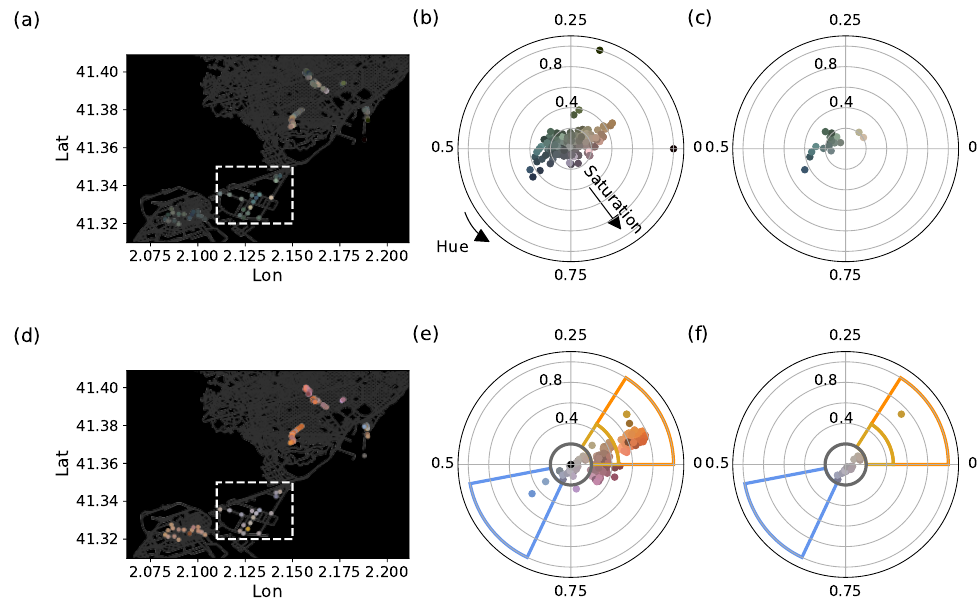
Figure 10. Analysis of an unlabelled dataset with the ISS ( top row ) and NightUp ( bottom row ). ( a , d ) Localisation of the streetlights photographed for the unlabelled dataset. The colour of the marker corresponds to the extracted colour for that localisation with the corresponding data source. ( b , e ) H-S scatter plot of the extracted colours from the previous unlabelled dataset. ( c , f ) Same but for the boxed region in ( a , d